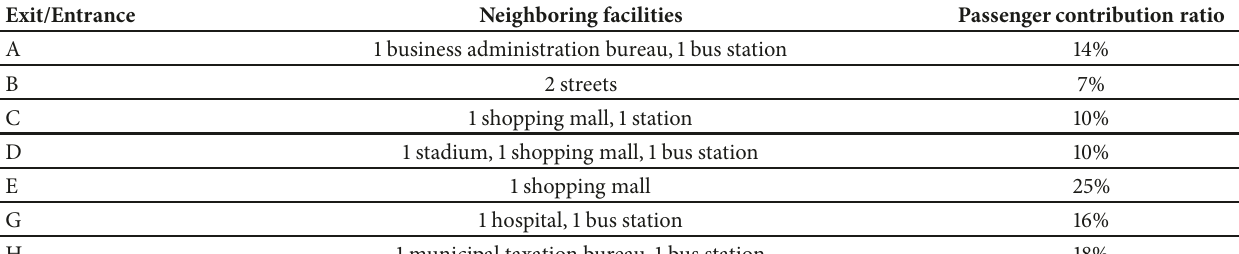
Table 2: Information of each exit.